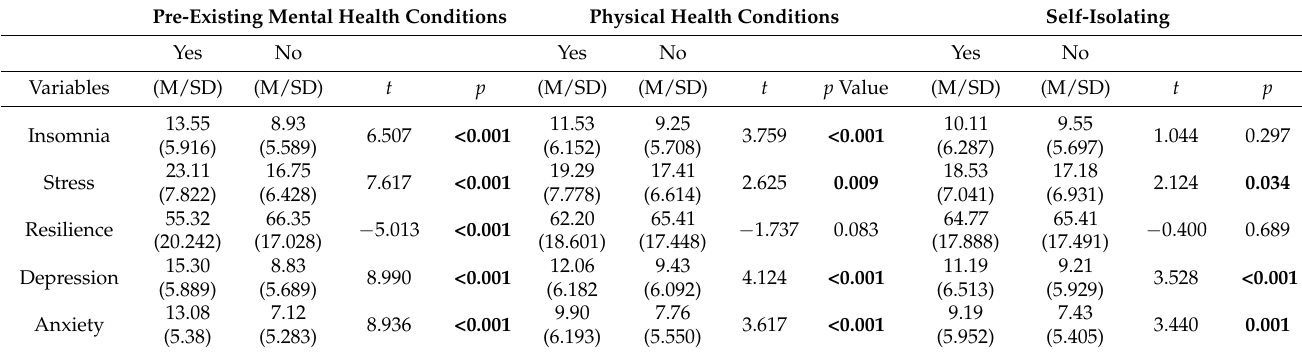
Table 2. An independent samples t -test comparing means for mental health outcomes and